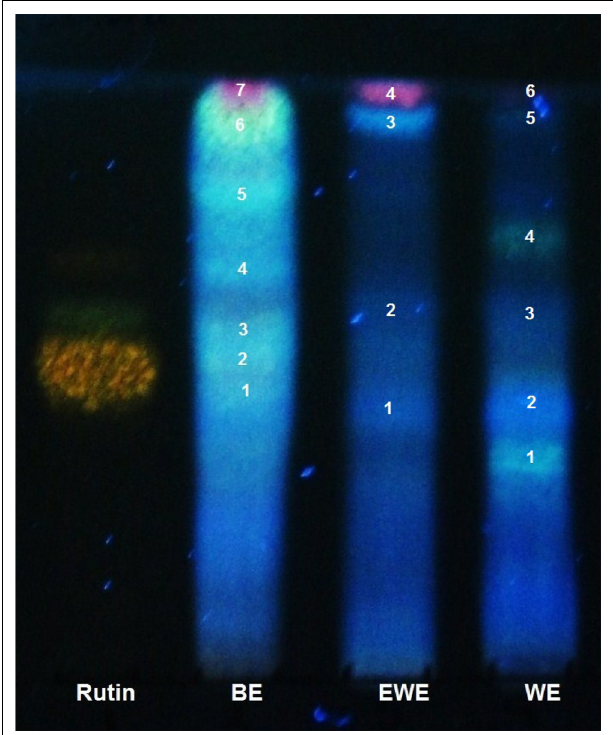
FIGURE 1 |Thin layer Chromatography of Bromelia plumieri leaves ; BE, butanol extract, EWE, ethanol:water extract;WE, water extract. Plates were visualized using diphenylborinic acid; the numbers indicate the detected compound.